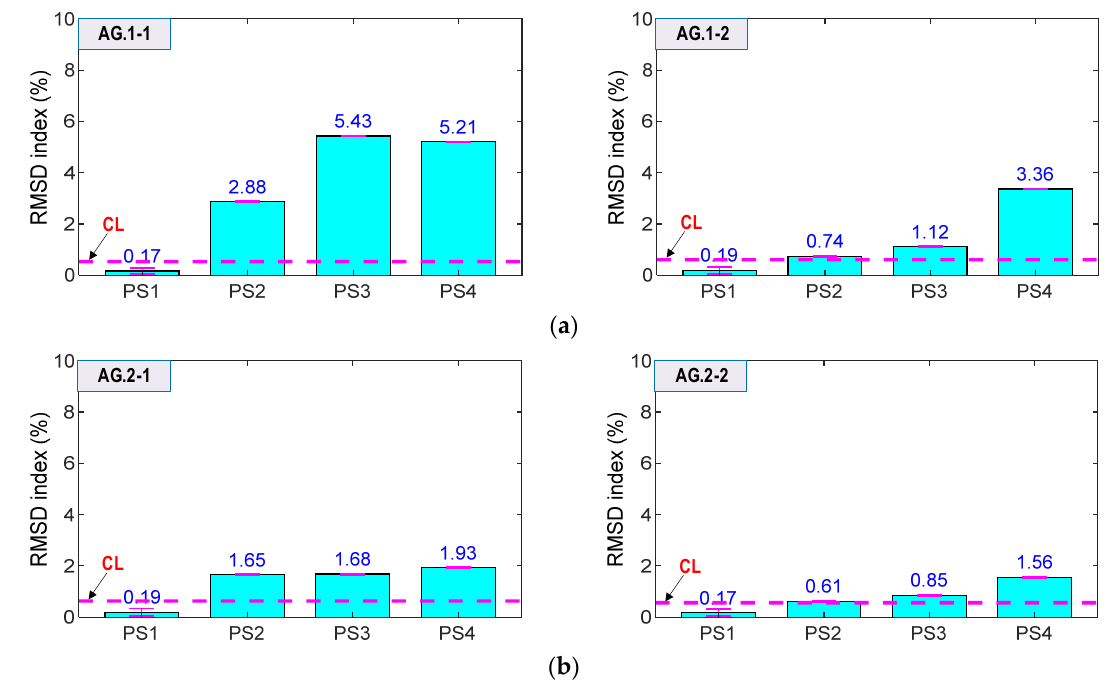
Figure 22. RMSD indices of impedance signals via smart rebars under loading cases PS1~PS4: ( a ) Smart rebars RB.1-1 and RB.1-2; ( b ) Smart rebars RB.2-1 and RB.2-2.